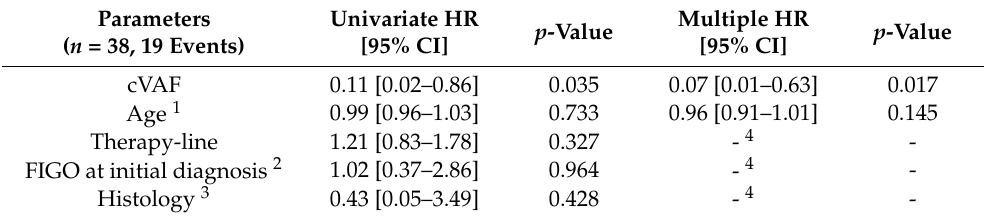
FIGO at initial diagnosis